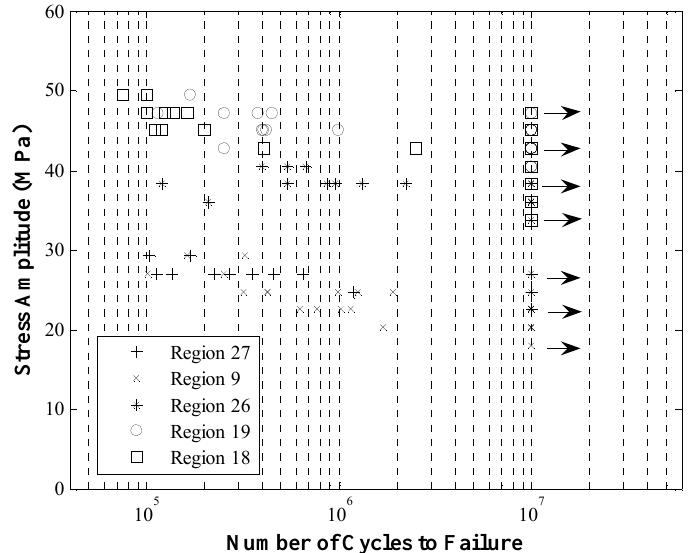
Figure 14. Fatigue test results obtained at different stress amplitude [7].